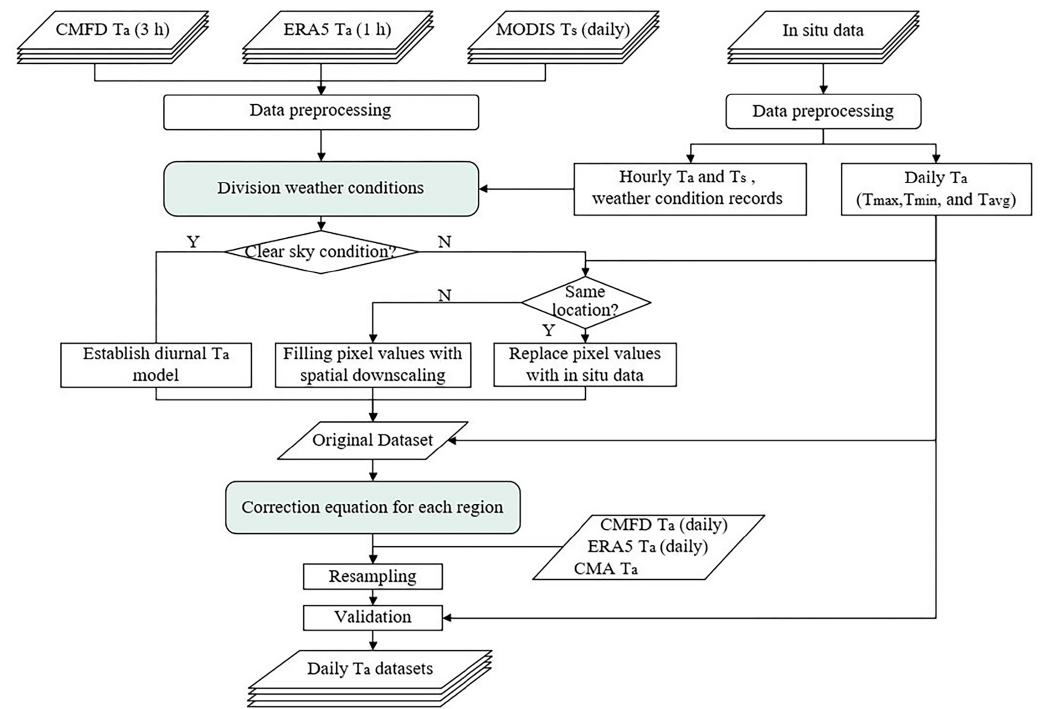
Figure 2. Summary flowchart of T a dataset